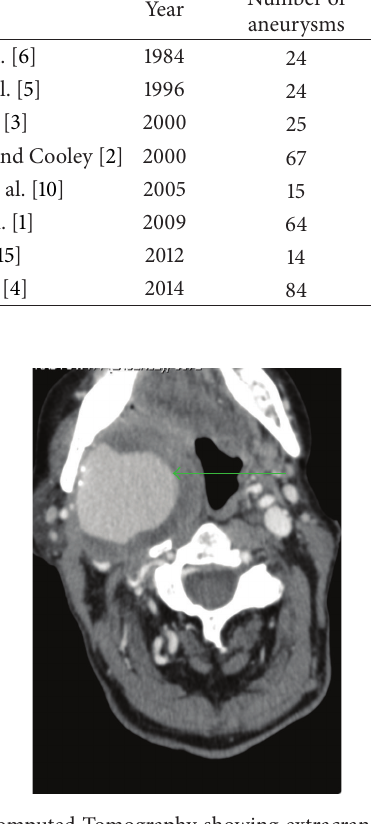
Figure 1: Computed Tomography showing extracranial aneurysm of right internal carotid artery (arrow).